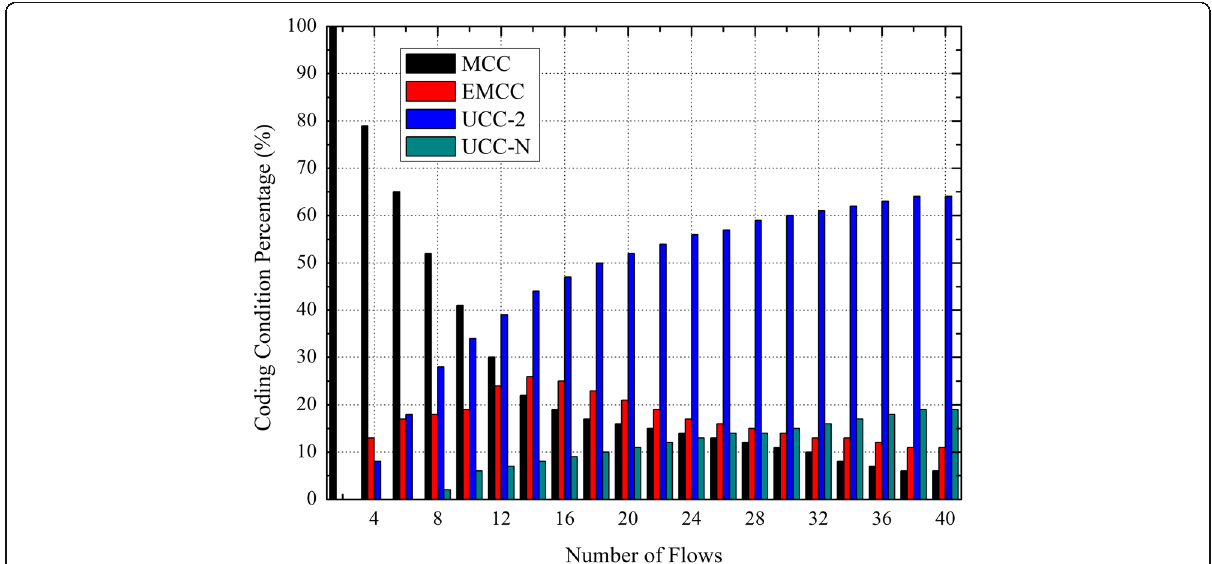
Fig. 30 Coding condition percentage of NAER under different number of flows in random network. Figure 30 shows the coding condition percentage comparison of NAER under different number of flows in random